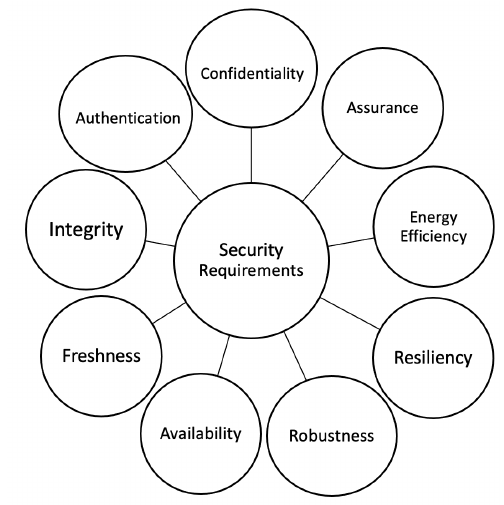
Figure 2. 6LoWPAN security